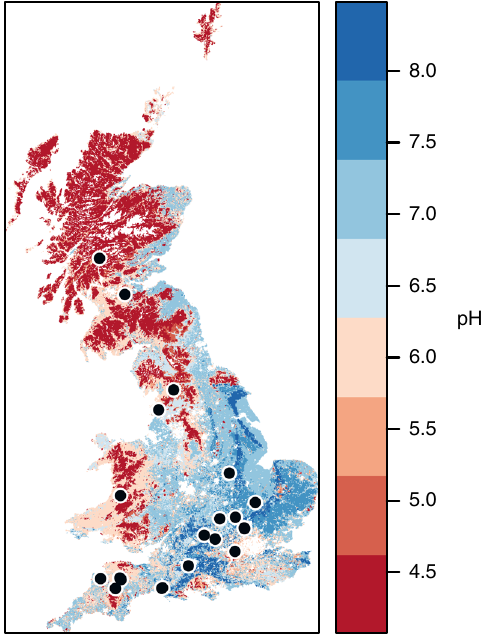
Fig. 1 Geographical distribution of sampling sites. Soil sampling locations across Britain are displayed over a soil pH map of Britain created using maptools [https://CRAN.R-project.org/package = maptools] and gstat [https://CRAN.R-project.org/package = gstat] packages under the R environment software; pH data was derived from the UK Soils portal (ukso. org). Soils were sampled from 56 sites, and 21 local land use contrasts were available to study the effects of land use intensi fi cation. Symbols of sites